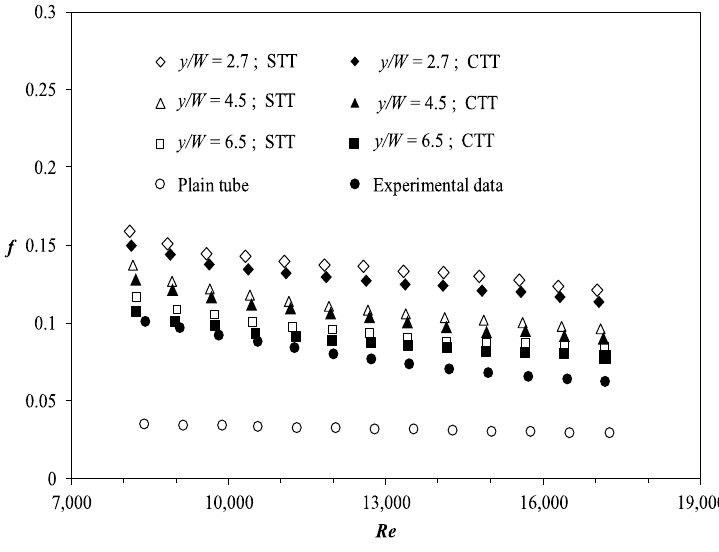
Figure 7. Friction factor for various CTTs and STTs.